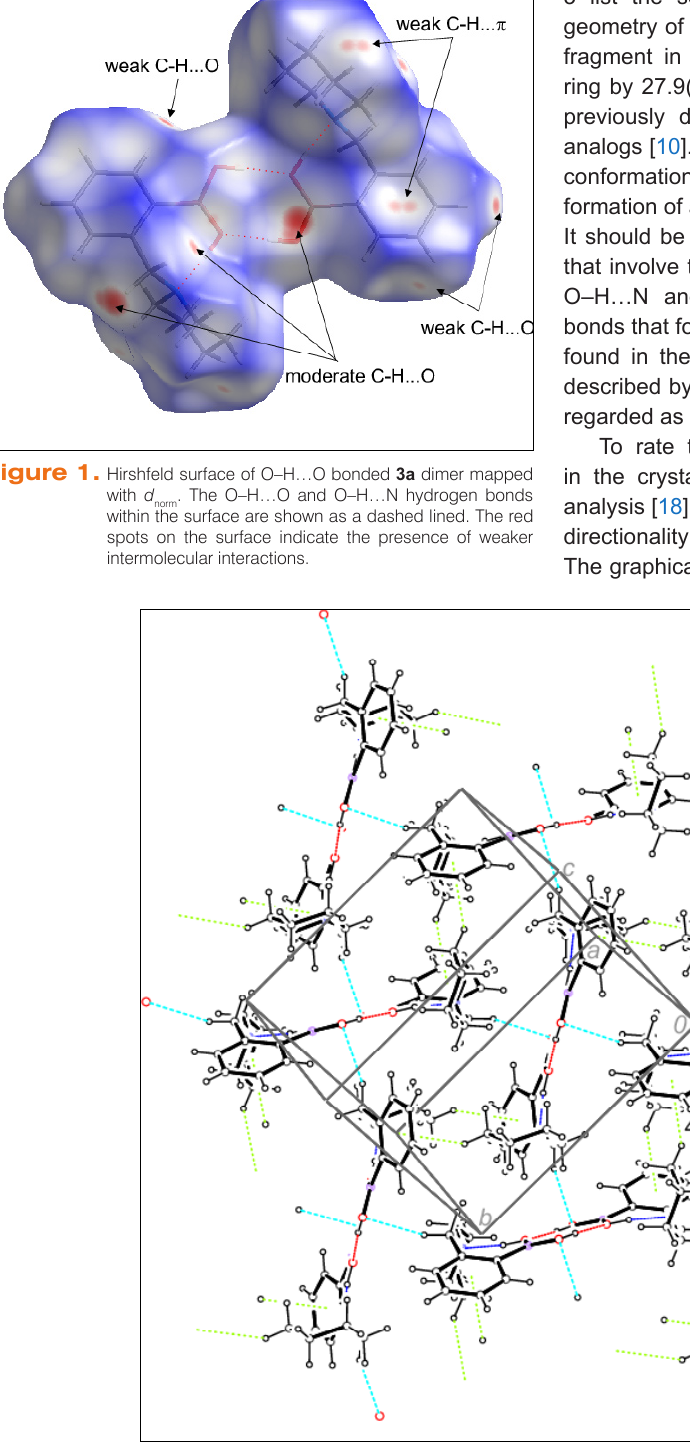
The square-grid layer structure of 3a directed by C–H…O hydrogen bonds and enhanced by weak C–H… p interactions. View towards the (–101) plane. H-bonds are presented as dashed lines and labeled from 1 to 4 in order: N–H…O (intramolecular), O–H…O, C–H…O and C–H… p